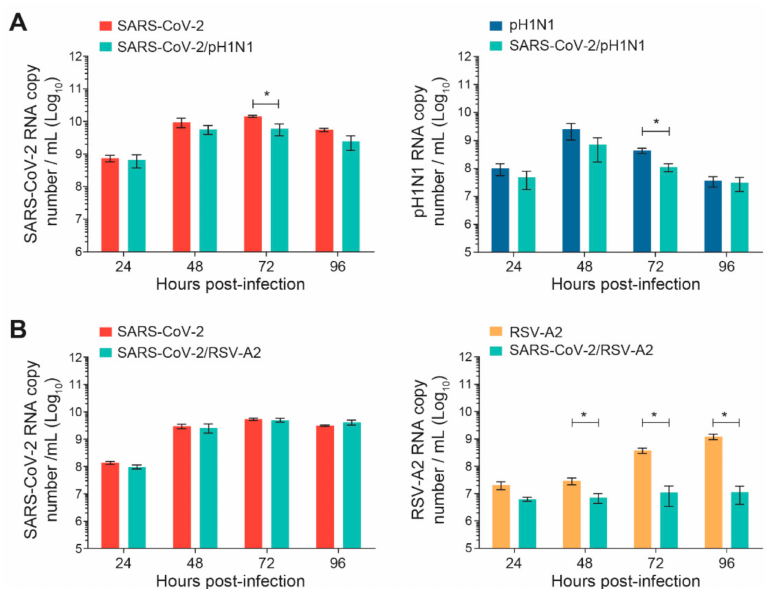
Figure 2. Replication kinetics of SARS-CoV-2 and influenza A(H1N1)pdm09 or RSV-A2 on nasal human airway epithelium (HAE) during simultaneous infections. Nasal HAE was simultaneously infected with SARS-CoV-2 and influenza A(H1N1)pdm09 ( A ) or SARS-CoV-2 and RSV-A2 ( B ) at the apical pole. Single infections with each virus were performed in parallel. The MOIs were set at 0.015 (SARS-CoV-2/A(H1N1)pdm09 series) or 0.02 (SARS-CoV-2/RSV-A2 series) in single and dual infections. The viral loads of SARS-CoV-2, influenza A(H1N1)pdm09 and RSV-A2 were determined by RT-qPCR. Results represent the mean ± SEM of 2 independent experiments with duplicate HAE. * p < 0.05 by the Mann–Whitney test. pH1N1, influenza A(H1N1)pdm09